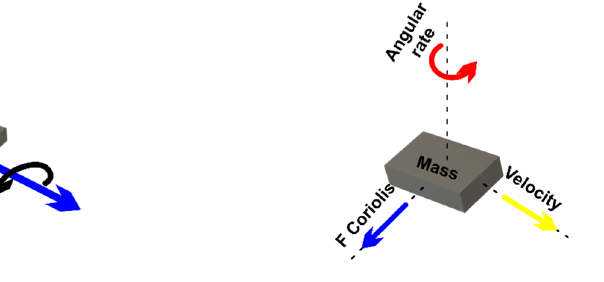
Figure 4. Gyroscope.